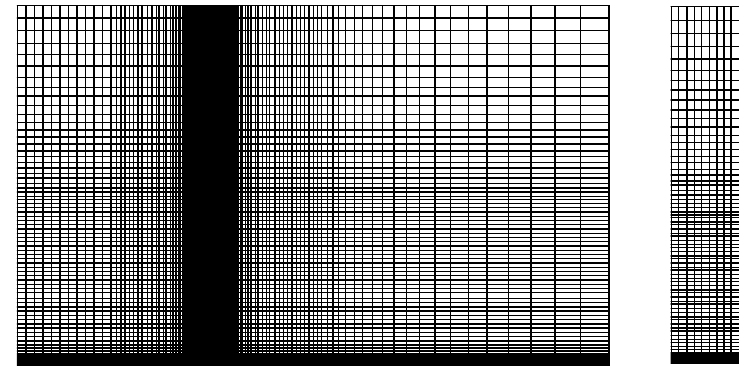
Figure 7. Computational grid for the CAARC building model.